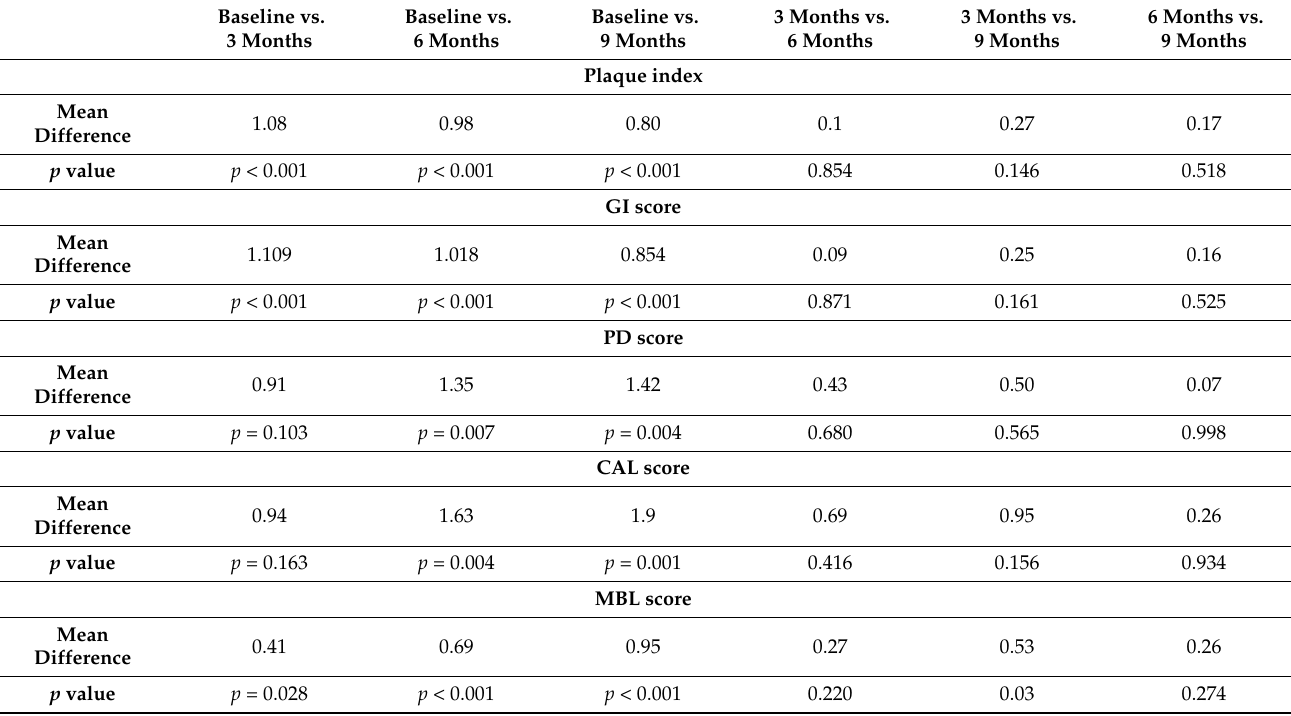
Table 2. Repeated measurements of ANOVA followed by Bonferroni’s Post-hoc test (Plaque index, Gingival index, Probing depth, Clinical attachment level, Marginal bone loss) for test